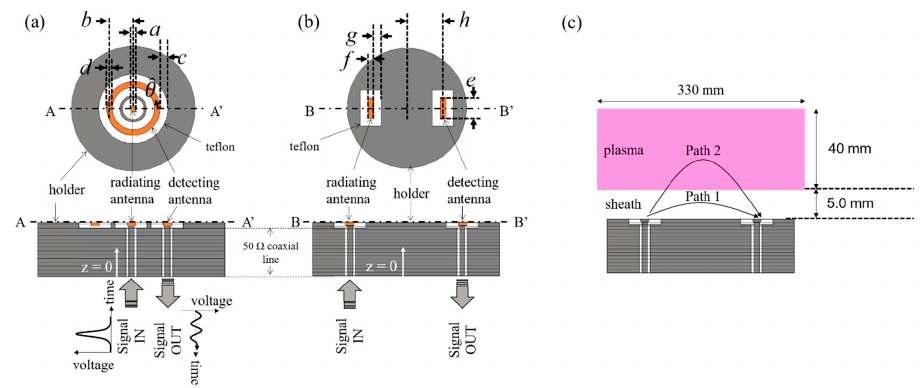
Figure 1. Schematics of the ( a ) ring-type cutoff probe (RCP) and ( b ) bar-type cutoff probe (BCP), with various geometrical parameters: a —antenna diameter; b , h —antenna distances; c , g —dielectric thickness; e —antenna length; d , f —antenna widths. ( c ) Geometry of the plasma and sheath.